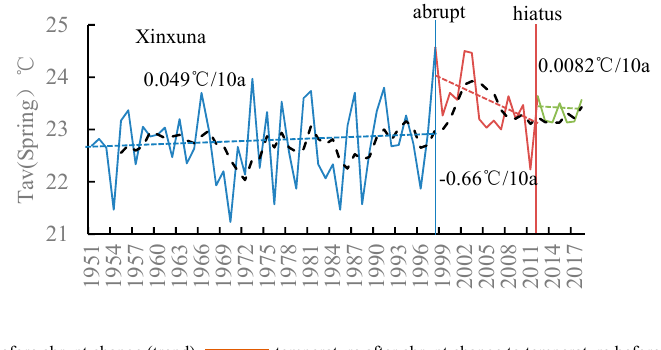
Figure 1. The process of determining the years of abrupt change, the warming (cooling) hiatus, and the end of the warming (cooling) hiatus.